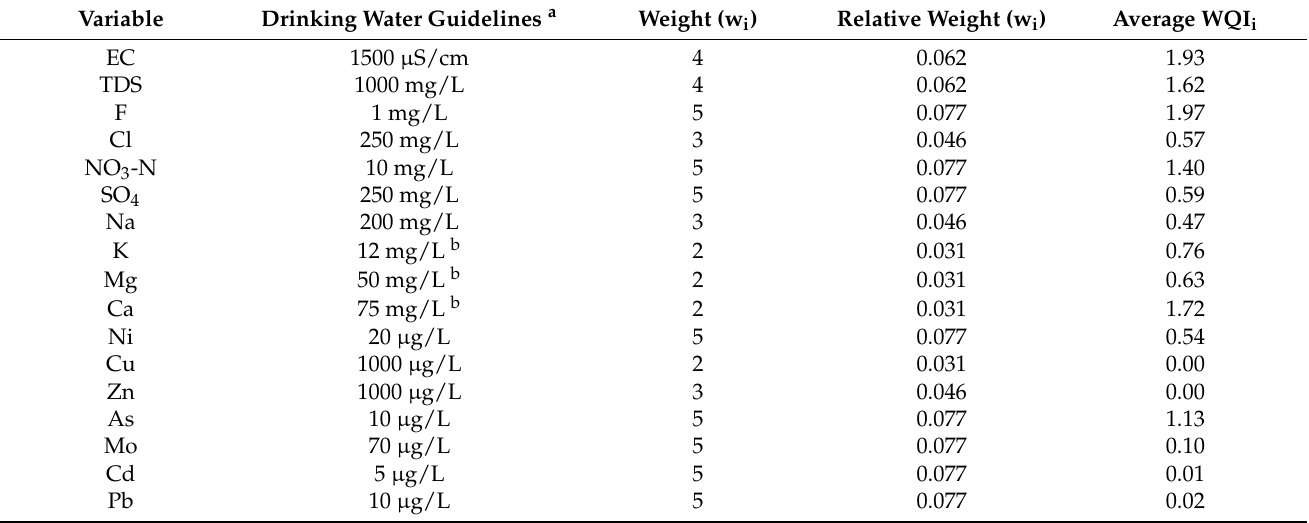
Table 1. Relative weight and limit values of individual variable, and the calculated average WQI i .